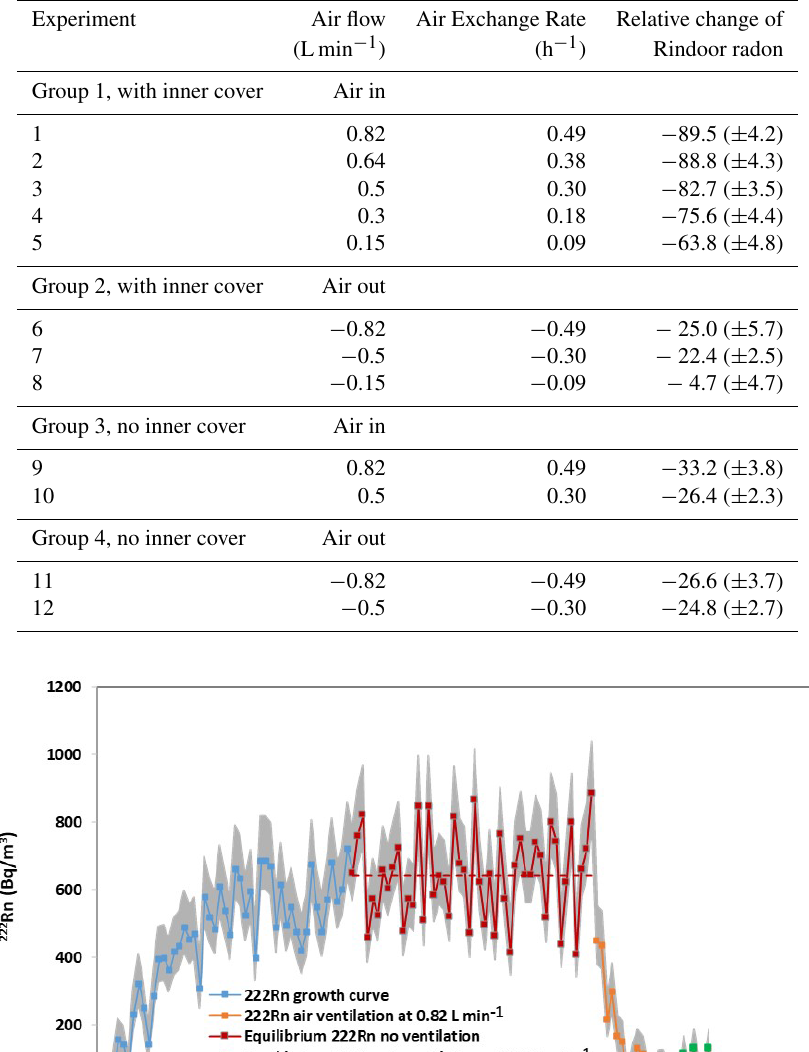
Table 2. Relative change of Indoor Radon (RIR) in the model room with and without the plasterboard inner covers in a series of experiments where outdoor air was introduced in the model room or indoor air was extracted from the model room at different air flow and air exchange (ACH) rates.